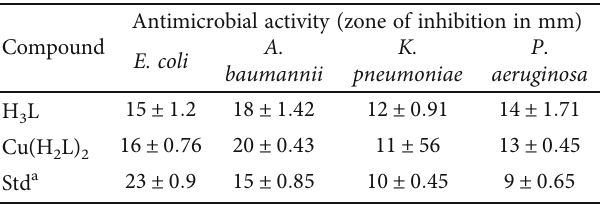
L and Cu(H L) . 3 2 2